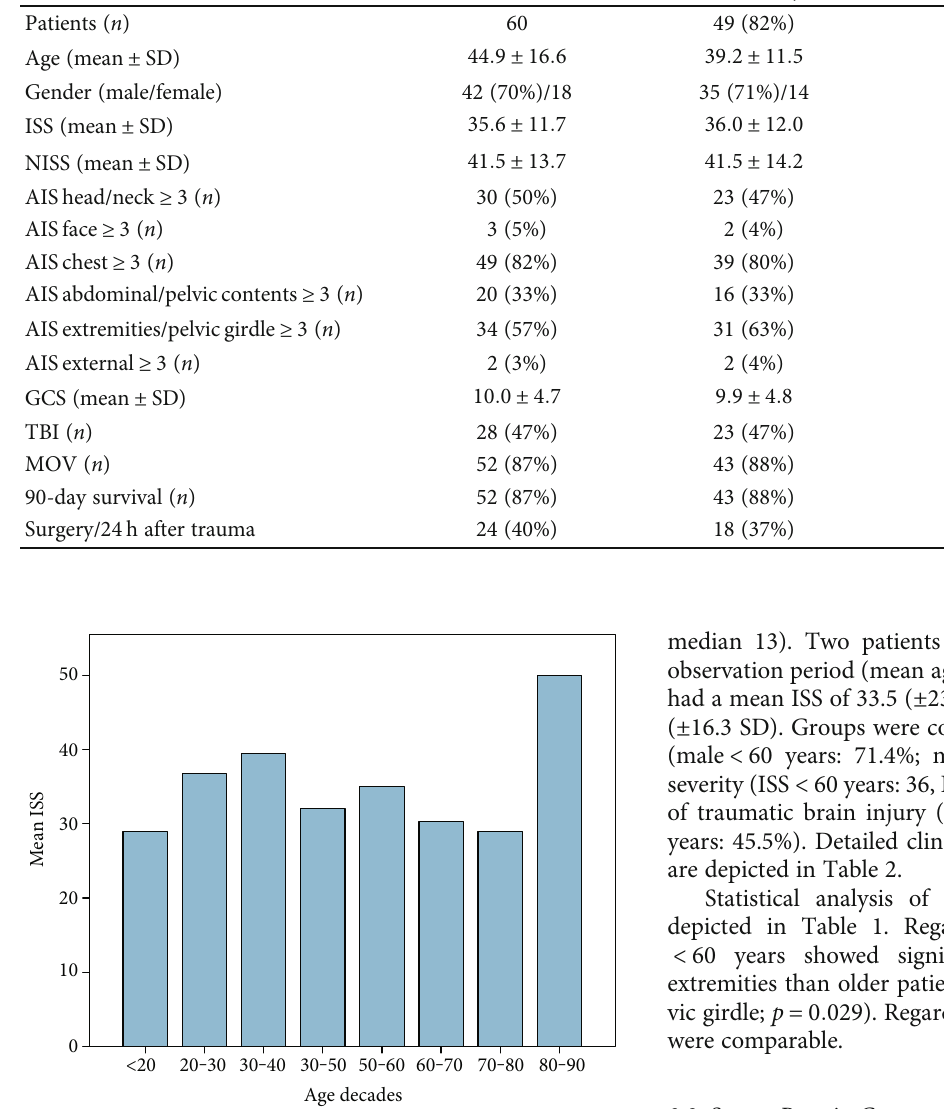
Figure 1: Mean ISS of all patients according to age decades ( n = 60 ). The results show higher ISS scores between 20 and 40 years and over the age of 80